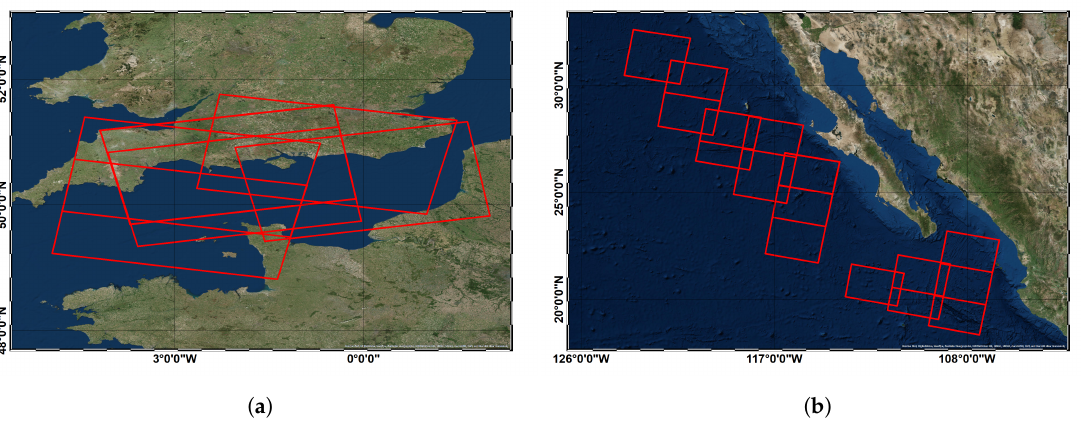
Figure 2. Location of the Sentinel-1 frames for the two test case sites: ( a ) English Channel and ( b ) Mexico. Table 1. Characteristics of the Sentinel-1 synthetic aperture radar (SAR)